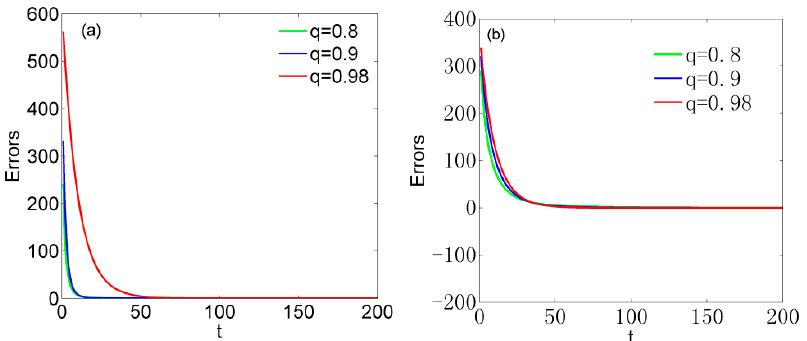
Figure 9. Effect of q on the synchronization time. ( a ) Synchronization time for different q in case 1; ( b ) synchronization time for different q in case 2.